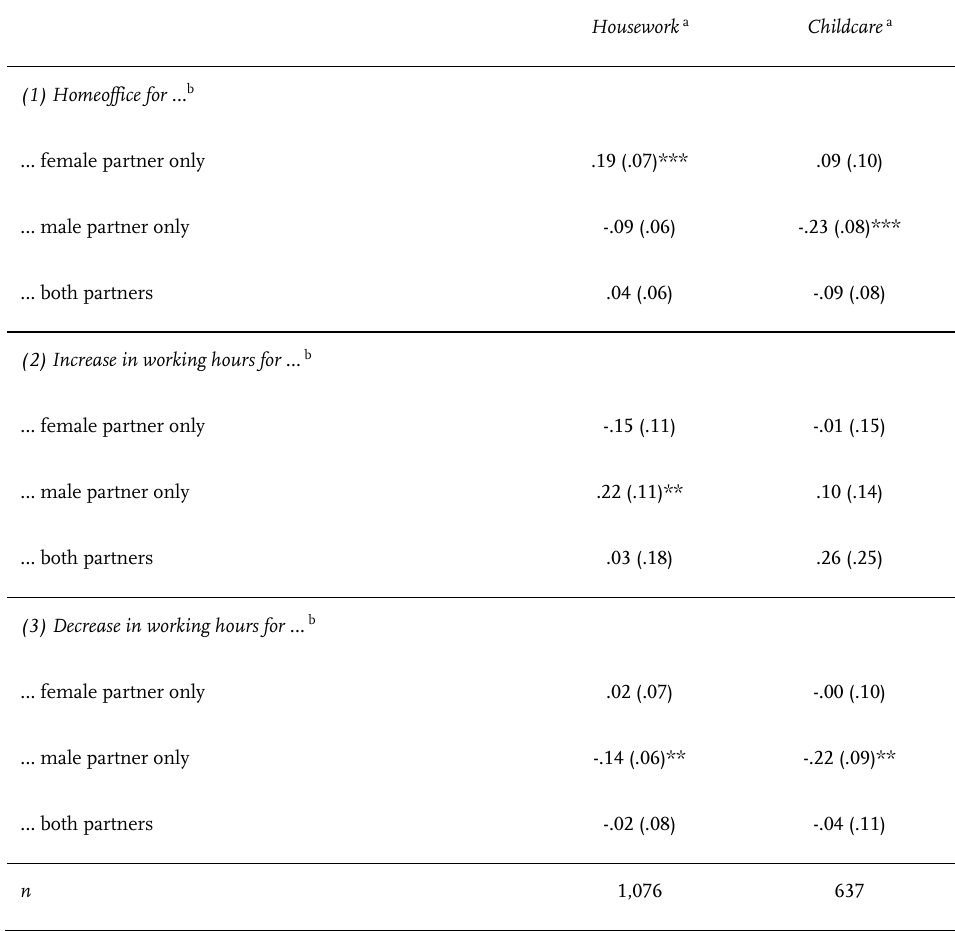
Table 3 : Within-couple dynamics in the division of housework and childcare during the Corona crisis, by changes in couples’ employment arrangements (bivariate linear regression coefficients; standard errors in